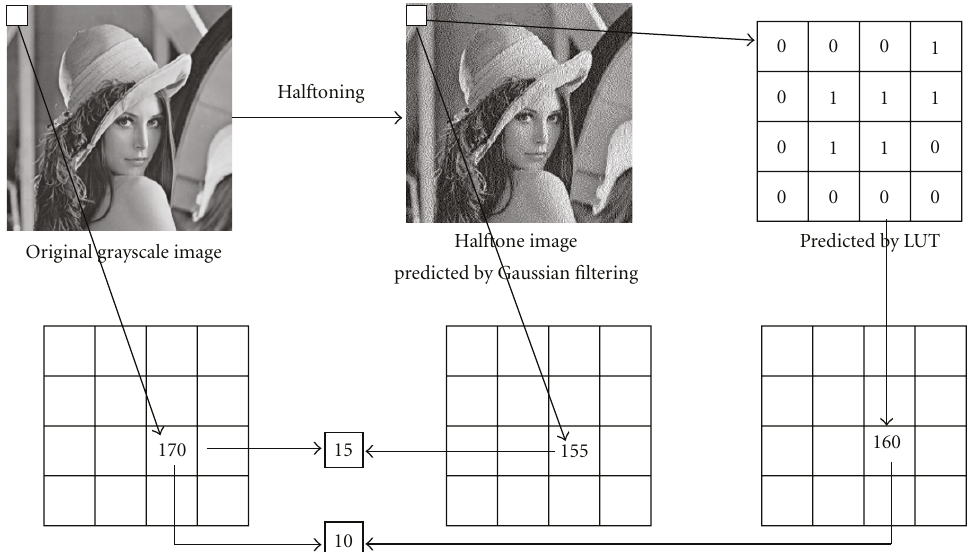
Figure 6: An example for the comparison of image quality loss using two di ff erent methods.